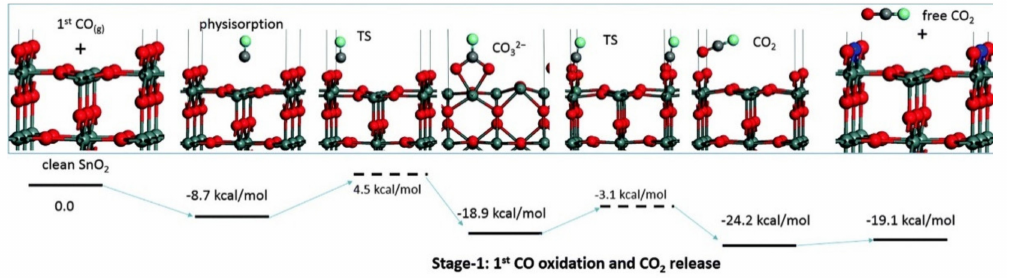
Figure 11. Direct reduction of the (110) surface of SnO 2 during CO adsorption. Reproduced with permission from Reference